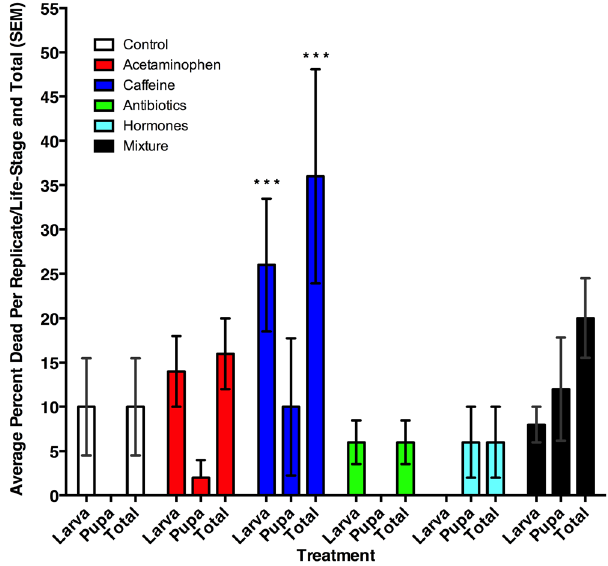
Figure 1. Average (SEM) mortality of larvae, pupae, and total insects for each treatment group. *** Denotes significant difference ( α = 0.05) relative to the control.